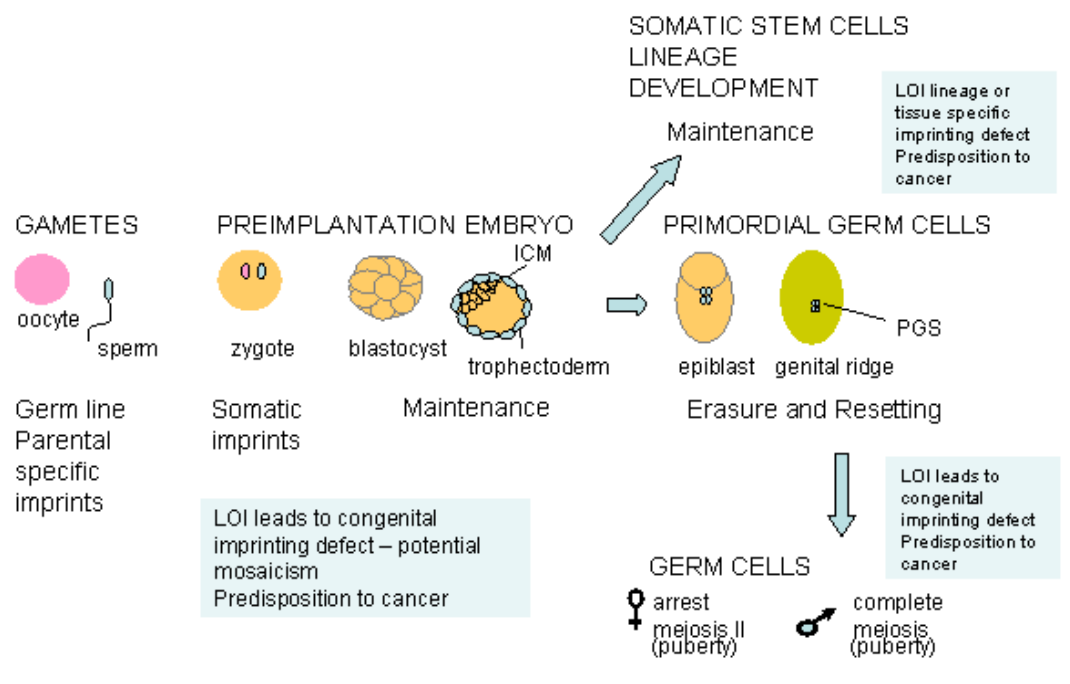
FIGURE 1. Ontogeny of imprinting and windows within development in which imprinting can be lost. Oocytes and sperm carry parental-specific germline imprints that were established during germ cell development after PGCs had migrated from the epiblast to the genital ridge. These imprints are stable and resist the genome-wide demethylation and remethylation that occurs after fertilisation during the preimplantation period. Additional somatic imprints are acquired after fertilisation and these, together with the germline imprints, are maintained during lineage development. Events that lead to LOI at the preimplantation stage are failure to establish the somatic imprints and failure to maintain imprinting. This could result in epigenetic mosaicism and, depending on the proportion of cells with LOI, could result in a congenital imprinting defect (such as Prader- Willi/Angelman syndrome; Beckwith Wiedemann syndrome [BWS]) or lineage-restricted LOI with less-severe developmental defects and potential to develop cancers. LOI can also occur after lineage development in somatic stem cells with even further lineage restriction. Global remodelling occurs during germ cell development such that imprints are erased and re-established according to the sex of the embryo so that the gametes will carry new parent-of-origin germline imprints. Mistakes occurring during erasure and establishment of the imprint at this stage will be inherited in the next generation if the gametes with defective imprinting contribute to